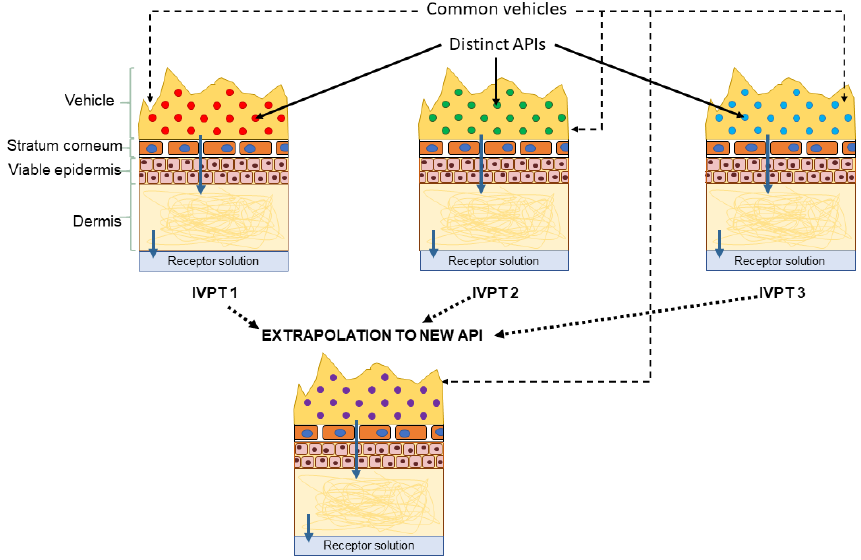
Figure 7. Proposed extrapolation workflow: the vehicle-specific parameters are learned from IVPTs conducted using a common vehicle but distinct active pharmaceutical ingredients (APIs). The learned parameters can inform future estimates of dermal absorption of novel APIs from the same vehicle.